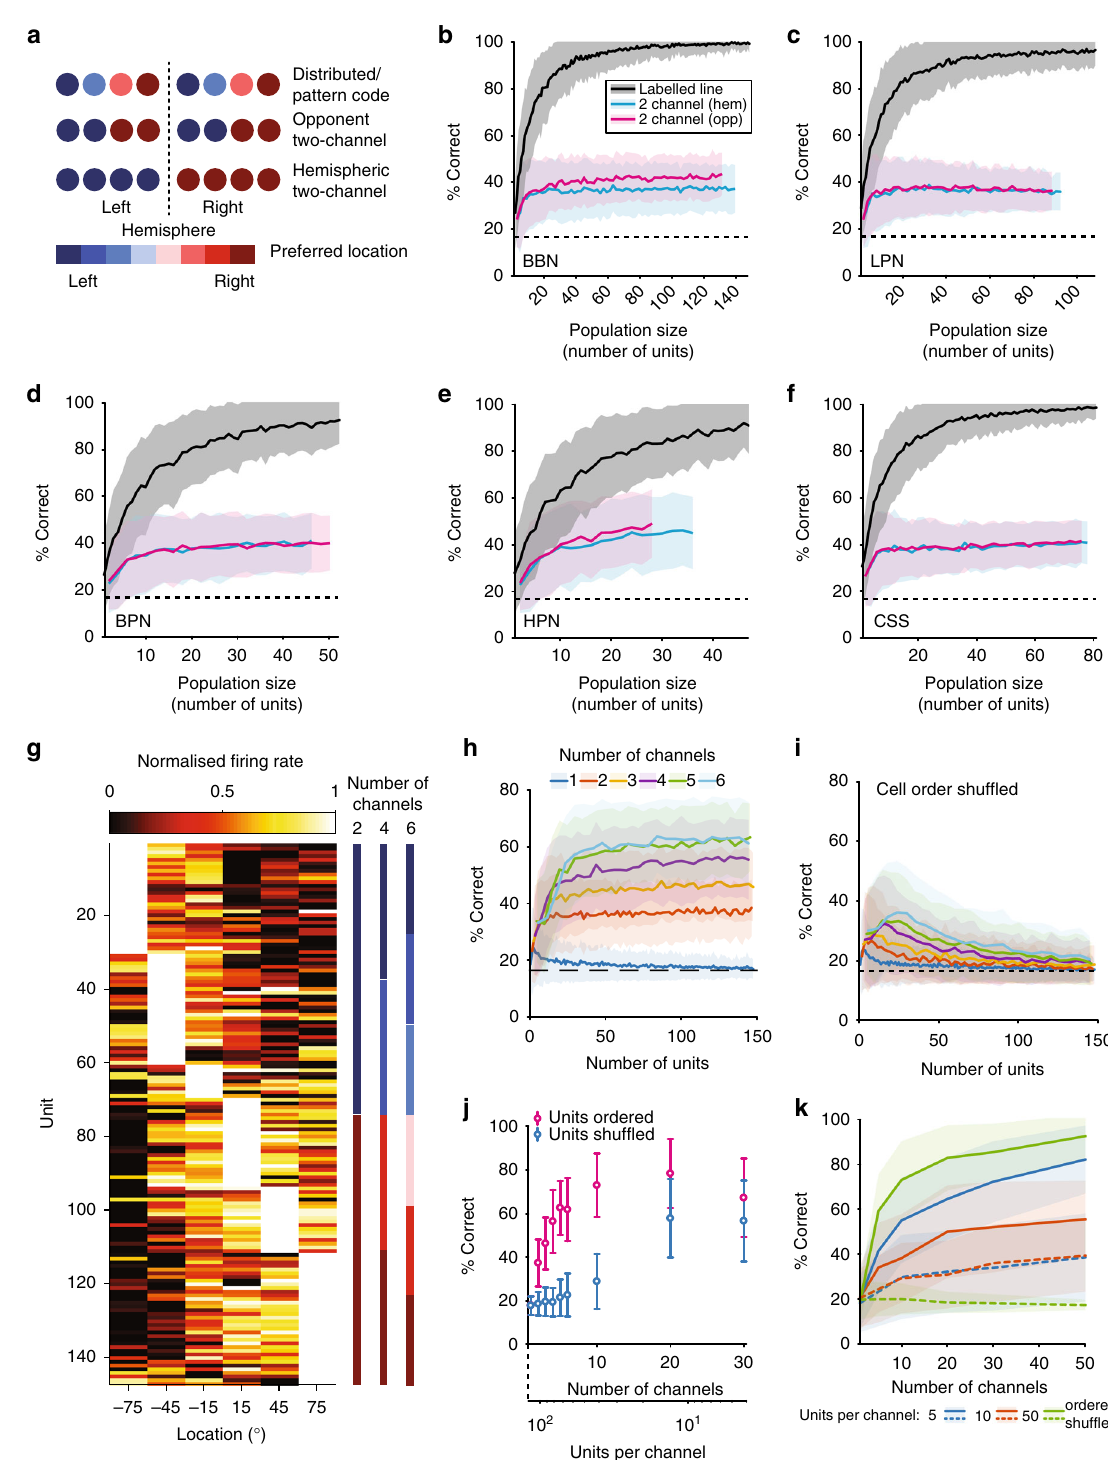
Fig. 7 Distributed model population decoding outperforms two-channel models. a Schematic of three possible spatial coding mechanisms. b – f Performance of the two-channel (hemispheric – blue, opponent – magenta) and distributed (grey) decoders in each stimulus condition from populations of neurons that had signi fi cant MI about location. Performance of each decoder was calculated as percentage of correctly classi fi ed individual trials. The dotted line indicates chance (1/6). The black line and coloured bands indicate the mean ± s.d. of the performance for 250 different random subpopulations of each size drawn from the full sample of cells. g Spatial receptive fi elds for all units used in the population analysis for BBN, ordered by best position. h Decoder performance for models with increasing channel numbers with units grouped according to g . i Decoder performance when units are randomly ordered and assigned to channels. j Comparison of decoder performance and shuf fl ed performance for a fi xed population of 120 cells divided into increasing numbers of channels. k Effect of the number of units per channel using the data from modelled unit responses for ordered and shuf fl ed units (see the